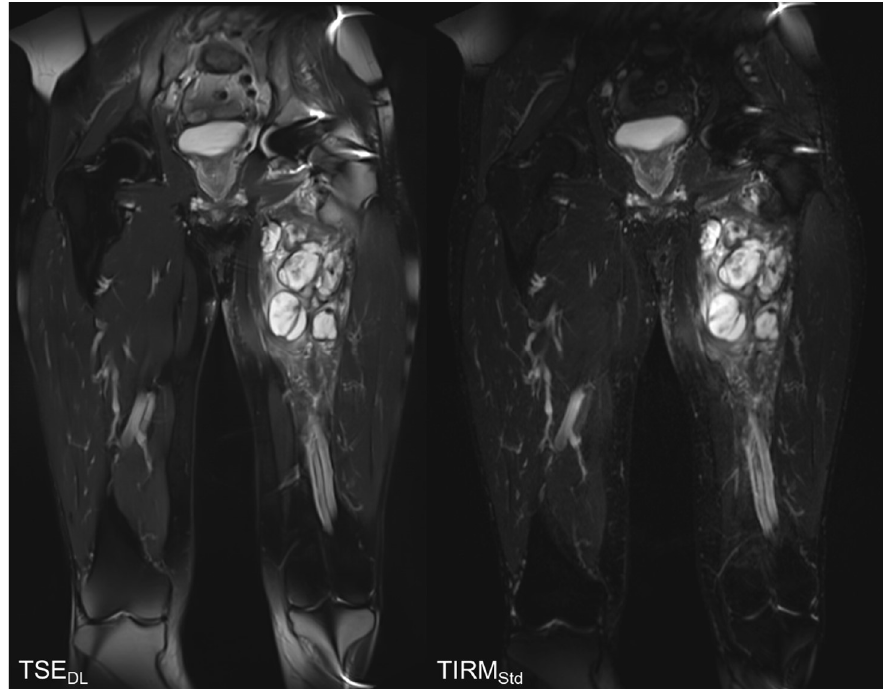
Figure 5. Follow-up MR examination of a 56-year-old male patient with histopathologically proven myxofibrosarcoma. T2w TSE DL allows a better delineation of the conglomerate tumor of the left thigh due to better image quality, noise, sharpness, and contrast.